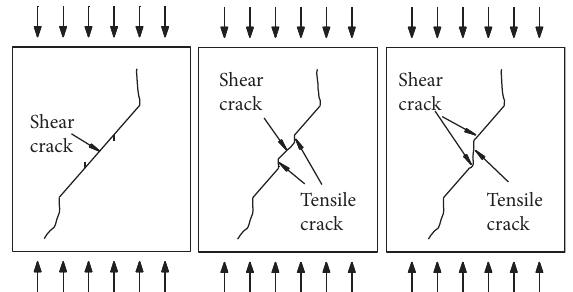
Figure 1: Shear failure and tensile shear failure of the rock bridge